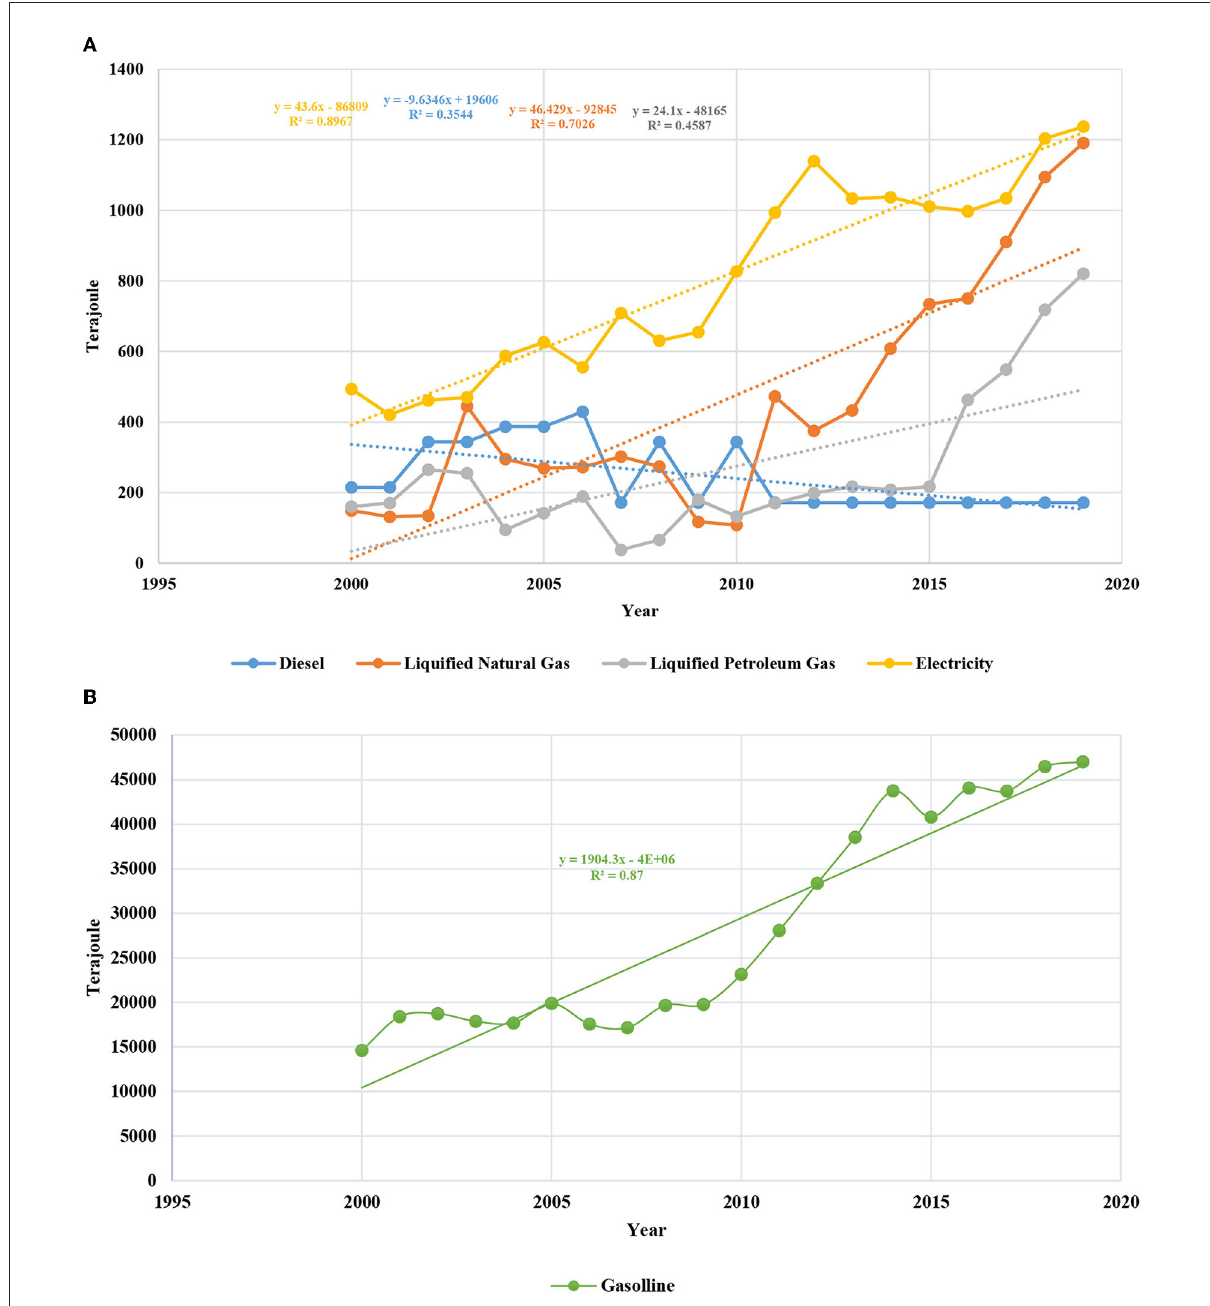
FIGURE7 (A,B) Energy use in agriculture in Nigeria (2000–2019). Source: FAOSTAT (2022).